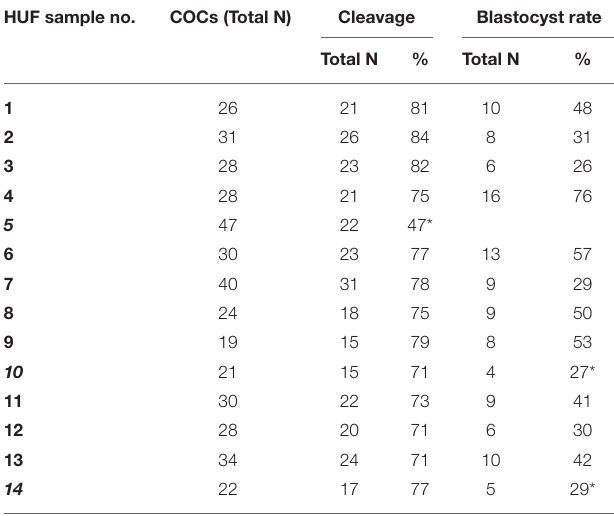
TABLE 2 | Percentage of cleavage (bovine cleaved embryos) and blastocyst rate (embryos that reached the blastocyst stage) after 8 days of culture with 1% of the respective